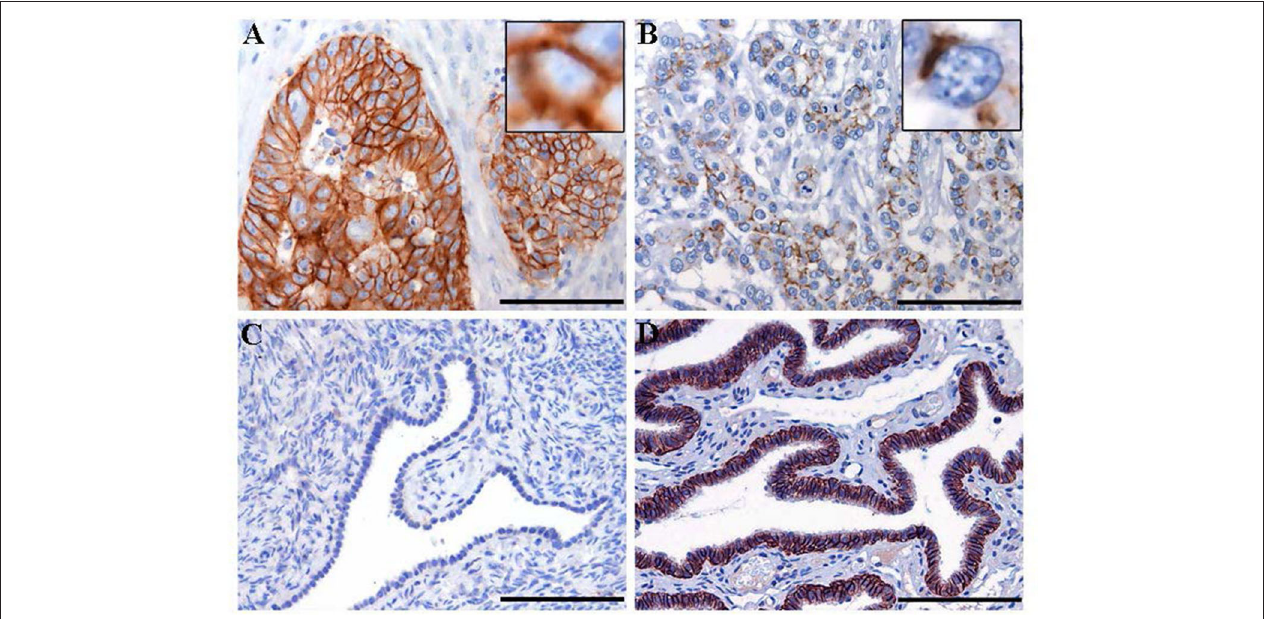
FIGURE 3 | Immunohistochemistry staining for claudin-7 expression in HGSOC tissue samples. Representative cases of primary HGSOC showing heterogeneous spectrum of strong and diffuse (A) rather than discontinuous (B) membranous staining. Ovarian mesothelium (C) and normal fallopian tube epithelium (D) , representing respectively the negative and postive control tissue for claudin expression, show absent rather than strong and diffuse membrane staining. Original magnification: 200x (scale bar 100 um).